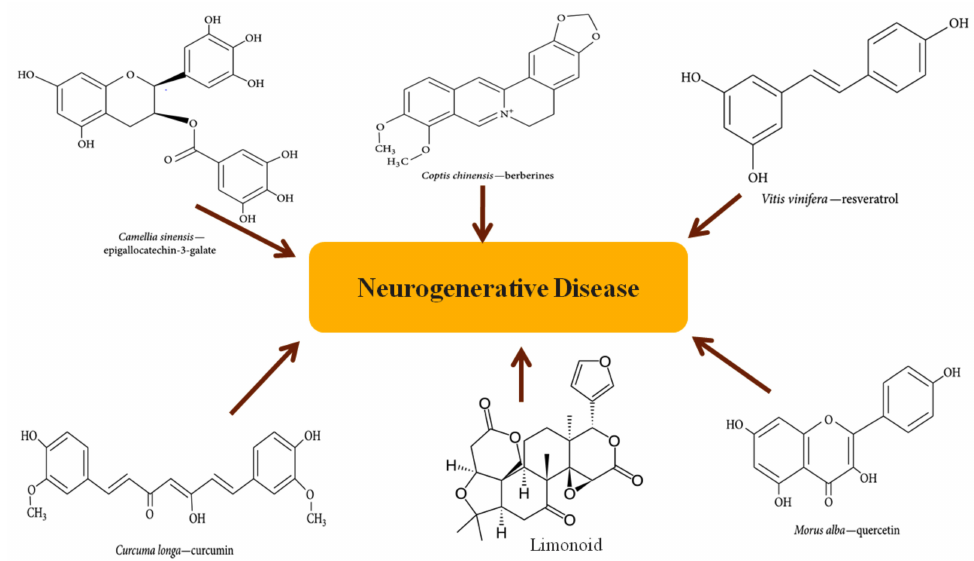
Figure 3. Structures of representative phytochemicals (epigallocatechin-3-galate, berberin, curcumin, resveratrol, quercetin,